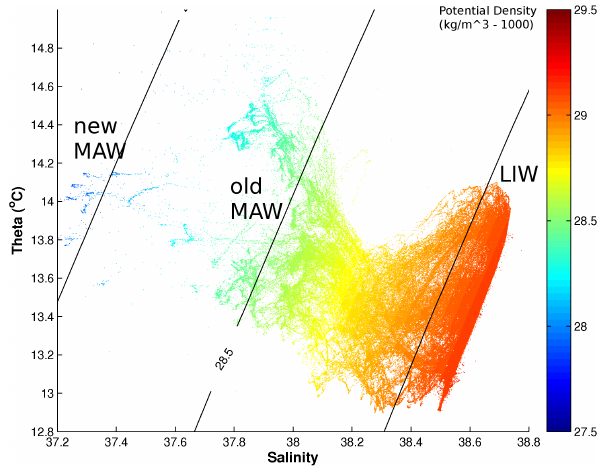
Figure 3. Cumulative θ − S diagram. LIW=the Levantine Inter- mediate Water; new MAW=the Modified Atlantic Water of more recent origin; old MAW=the Modified Atlantic Water reservoir of the Algerian